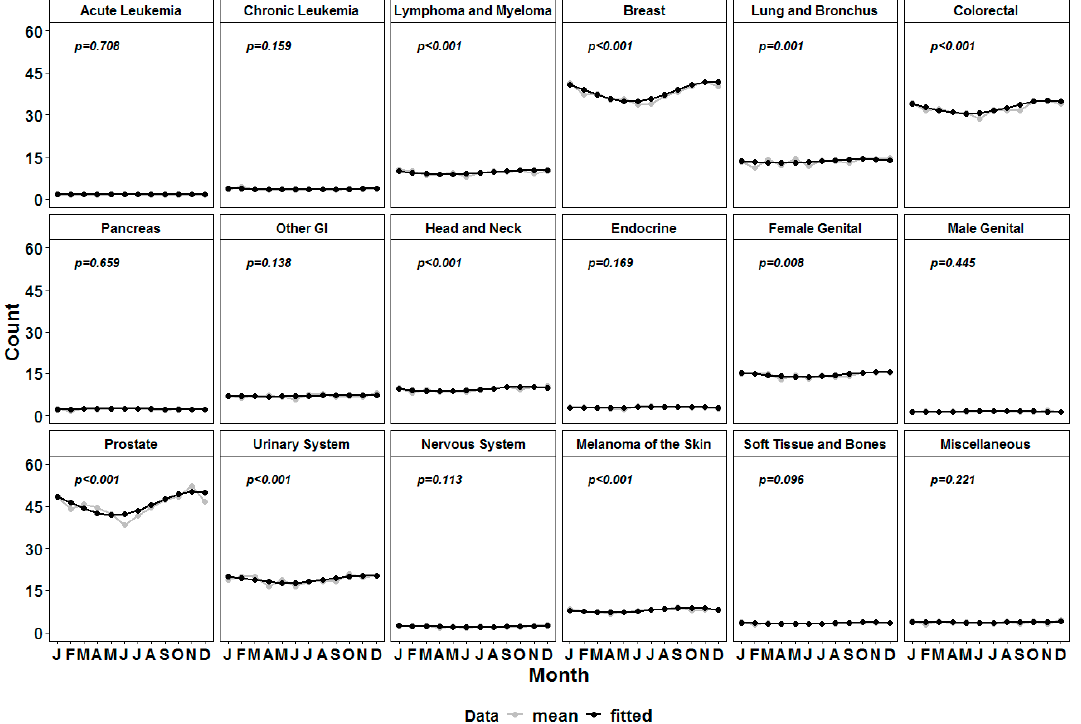
Figure 2. Curves of the number of deaths due to the fact of cerebrovascular diseases per month in the main cancers subtypes (in grey) versus the fitted cosinor model values (in black). Table 2. Parameters of the cosinor model fits to all cancer patients with death from cerebrovascular disease and defined subgroups.